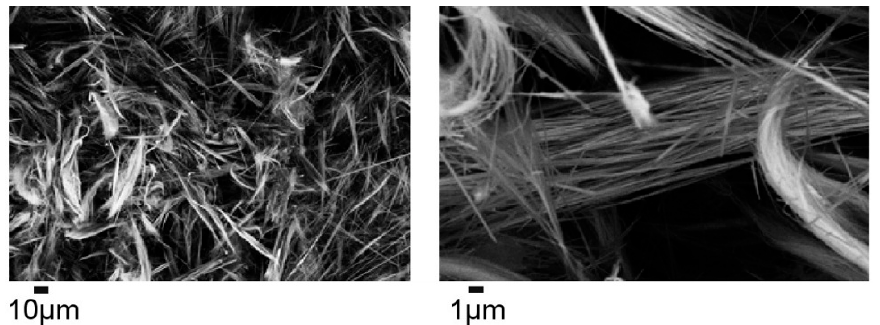
Figure 28. SEM images of Na 2 Mg 4 Si 6 O 16 (OH) 2 hydrosilicate (SNF) [148].